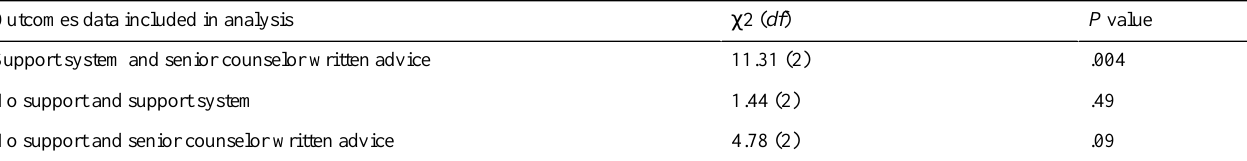
Table 1. Results of the comparison between null model and full models that included the expert label as a fixed effect to predict support type counselors had received when writing their reply (n=356).